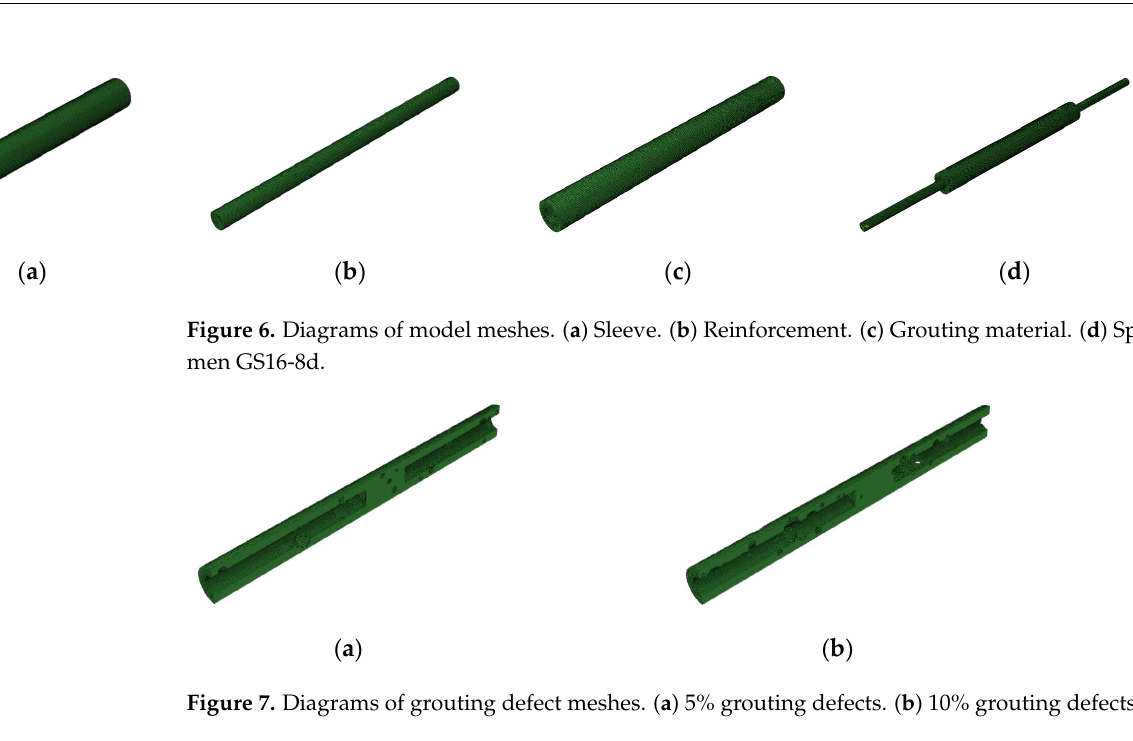
Specimen GS16-8d.